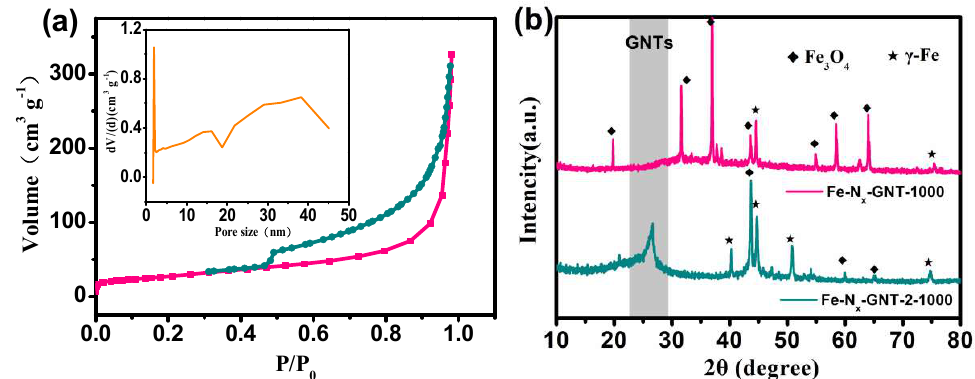
Figure 3. ( a ) Nitrogen sorption isotherm of optical Fe-N x -GNT-2-1000. The red line is the absorption line, and the green line is the desorption line. ( b ) XRD patterns of Fe-N x -GNT-1000 and Fe-N x -GNT-2-1000 of as-obtained Fe nanoparticle encapsulated in graphene layer.